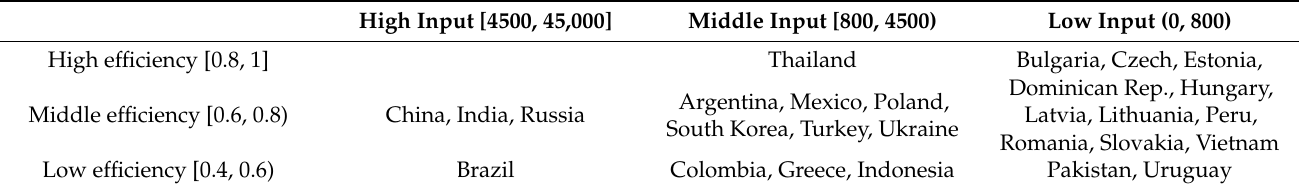
Table 3. Classification discussion of emerging